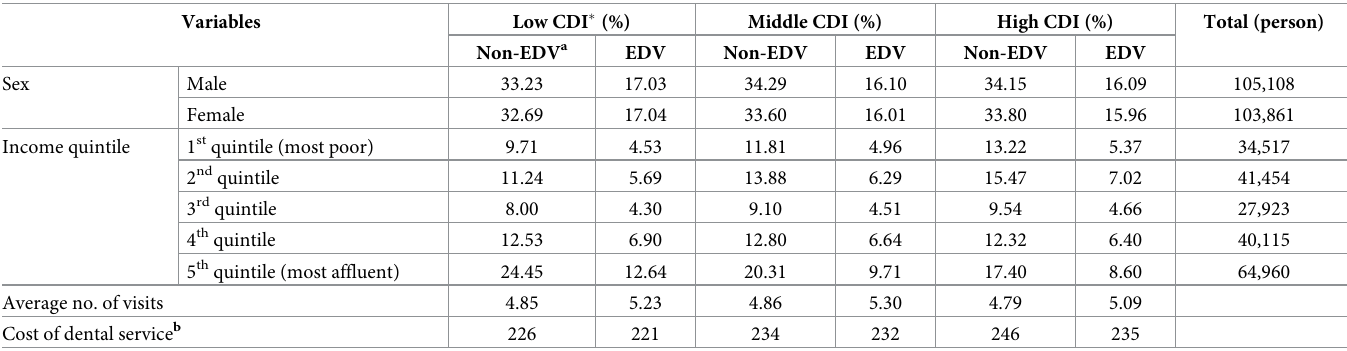
Table 1. General characteristic of the